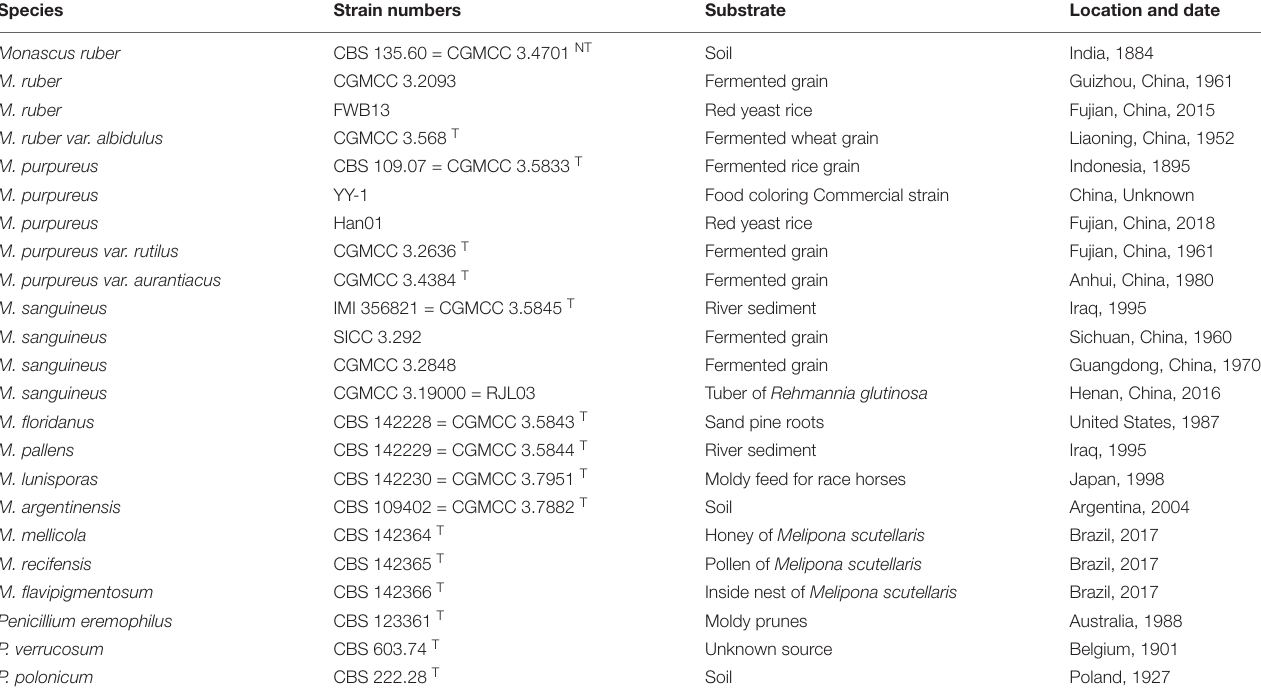
TABLE 1 | Strains used in this